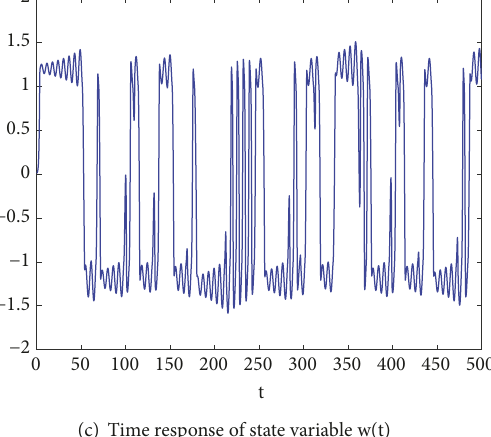
Figure 1: Time response of state variables of the memristor-based